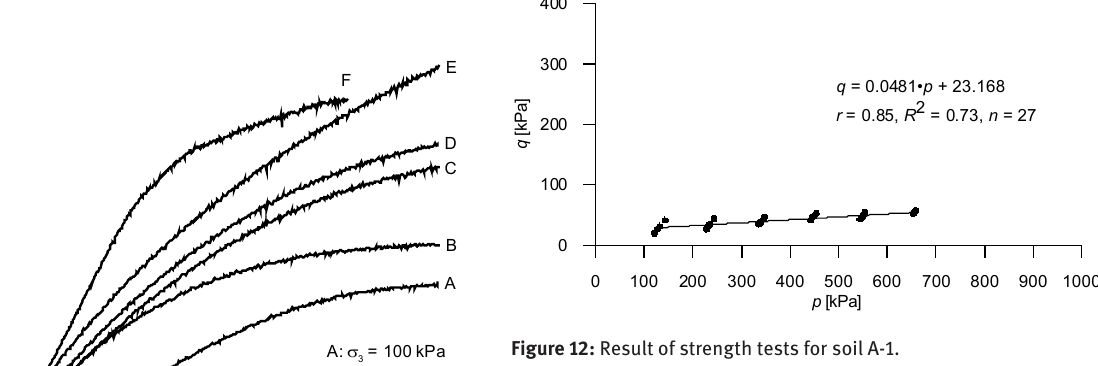
Figure 12: Result of strength tests for soil A-1.